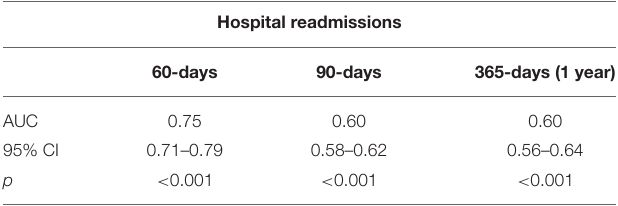
TABLE 3 | Secondary analysis of comparison between 30-day readmission and 60-, 90-, and 365-days (1 year) readmissions of patients hospitalized with